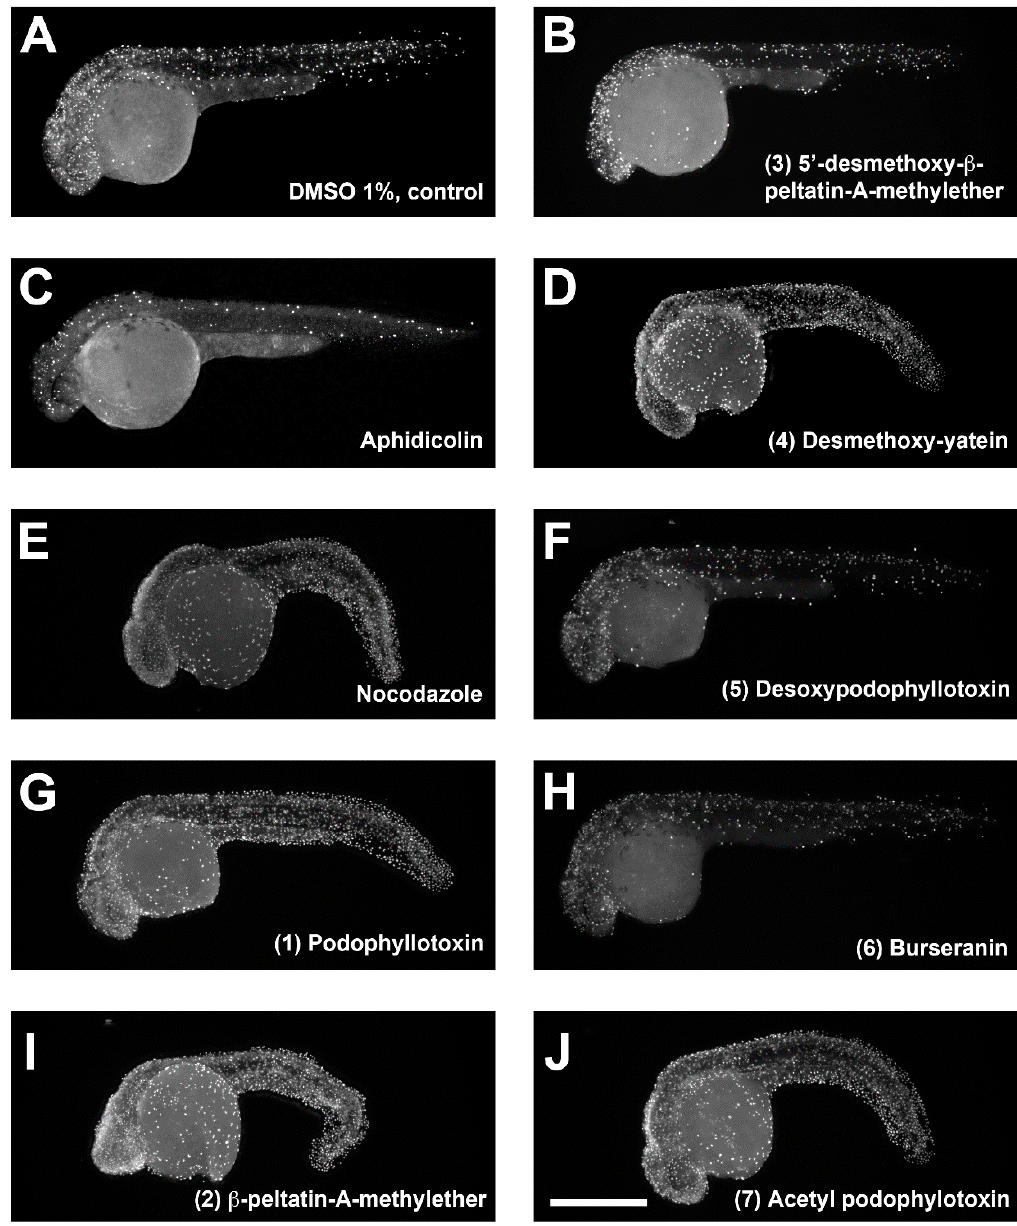
Figure 3. Whole-mount immunolocalization of H3S10ph in zebrafish embryos treated with B. fagaroides lignans. Wild-type 24 h post-fertilization zebrafish embryos were immunostained for H3S10ph after a 6 h treatment with different compounds. ( A ) Dimethyl sulfoxide (control), ( B ) Aphidicolin, ( C ) Nocodazole, ( D ) Podophyllotoxin ( 1 ), ( E ) β -peltatin-A-methylether ( 2 ), ( F ) 5 ′ -desmethoxy- β -peltatin-A-methylether ( 3 ), ( G ) Desmethoxy-yatein ( 4 ), ( H ) Desoxypodophyllotoxin ( 5 ), ( I ) Burseranin ( 6 ), ( J ) Acetyl podophyllotoxin ( 7 ). The images were visualized by confocal microscopy. Scale bar, 500 μ m.